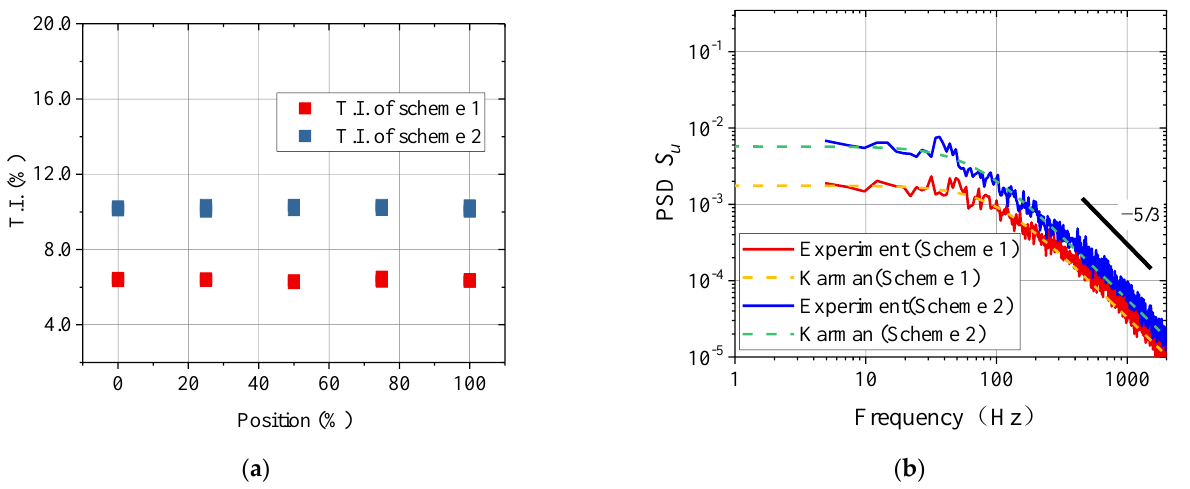
Figure 3. Description of turbulent flow parameters. ( a ) T.I. description at the position of leading edge; ( b ) power spectral density (PSD).